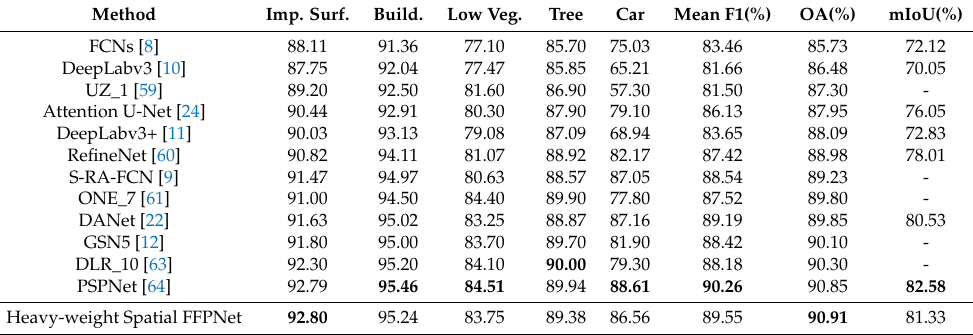
Table 6. Experimental results on the Vaihingen dataset; the values in bold are the